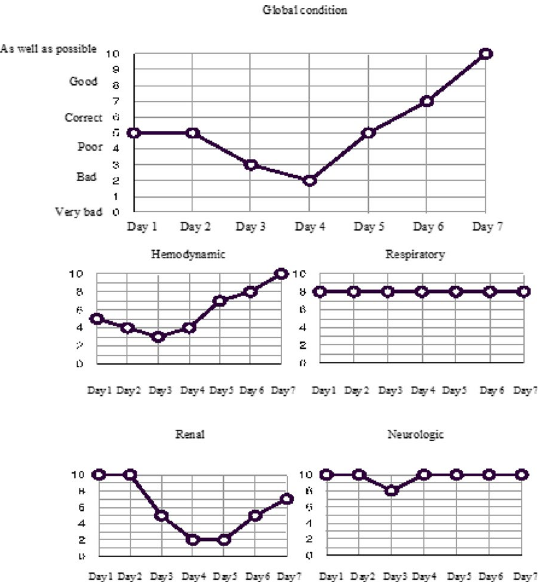
Fig. 1 An example of visual support